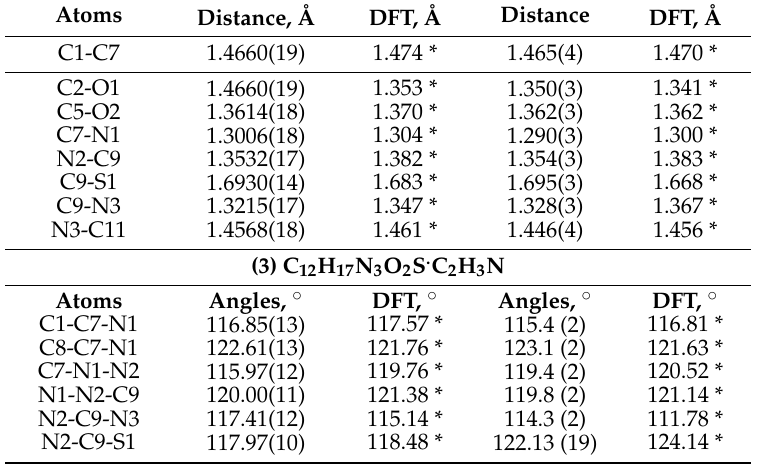
Figure 4. ( A ) ORTEP drawing of ( 4 ) showing the atom numbering scheme and 50% probability displacement ellipsoids of non-H atoms; (B, C) The molecular packing of ( 4 ) viewed along the a axis. Dashed lines indicate O–H … N, intramolecular hydrogen bonds and weak C–H … O, N–H … S intermolecular interactions. Hydrogen atoms not involved in hydrogen bonding have been removed for clarity. Table 3. Selected crystal and DFT * bond lengths (Å), bond angles (°), and torsion angles (°): ( 3 )–( 4 ). Atoms